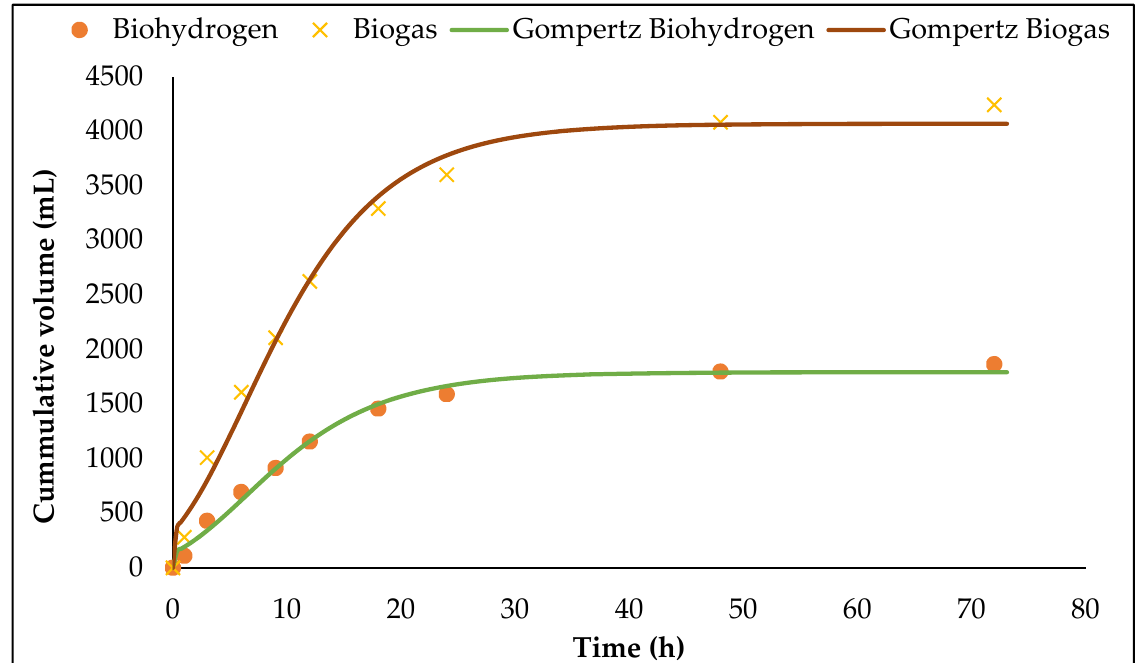
Figure 4. The cumulative biogas and biohydrogen produced from fermentation of AFEX OPEFB